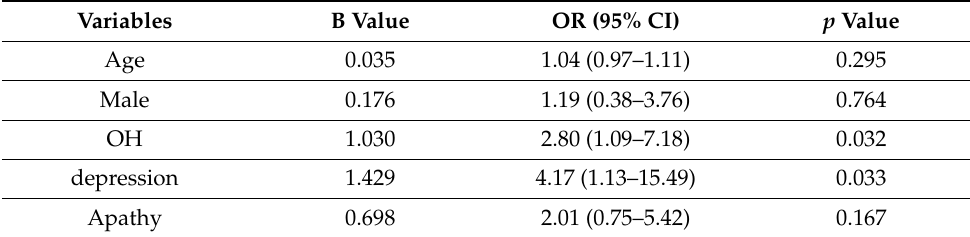
Table 2. Multivariate logistic regression to identify the factors associated with fatigue.